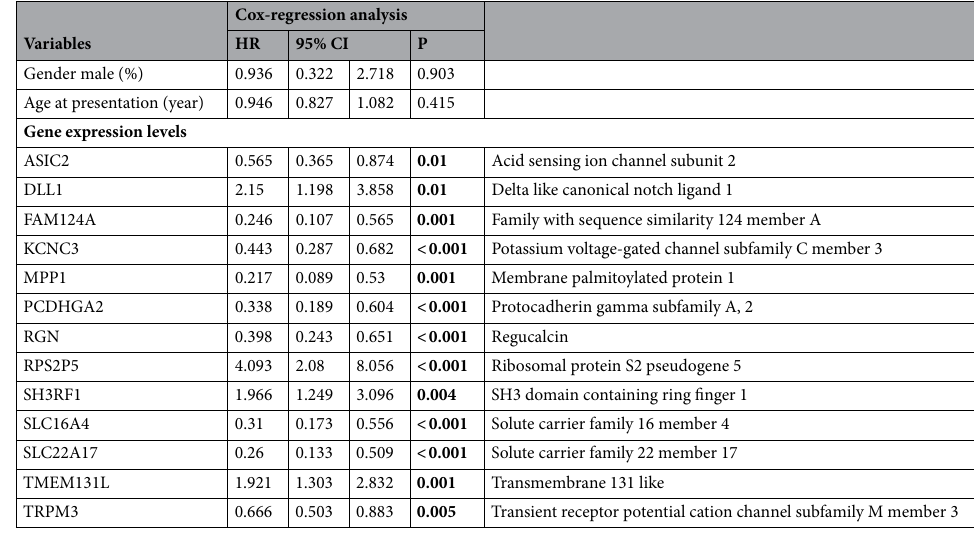
Table 1. A list of 13 leading genes significantly associated with overall survival. Significant values are in